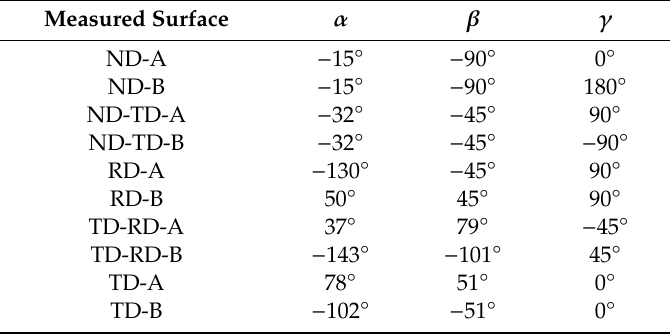
Table 1. The Eulerian angles of the specimen rotations in the case of the di ff erent measurements. Measured Surface α β γ ND-A − 15 ◦ − 90 ◦ 0 ◦ ND-B − 15 ◦ − 90 ◦ 180 ◦ ND-TD-A − 32 ◦ − 45 ◦ 90 ◦ ND-TD-B − 32 ◦ − 45 ◦ − 90 ◦ RD-A − 130 ◦ − 45 ◦ 90 ◦ RD-B 50 ◦ 45 ◦ 90 ◦ TD-RD-A 37 ◦ 79 ◦ − 45 ◦ TD-RD-B − 143 ◦ − 101 ◦ 45 ◦ TD-A 78 ◦ 51 ◦ 0 ◦ TD-B − 102 ◦ − 51 ◦ 0